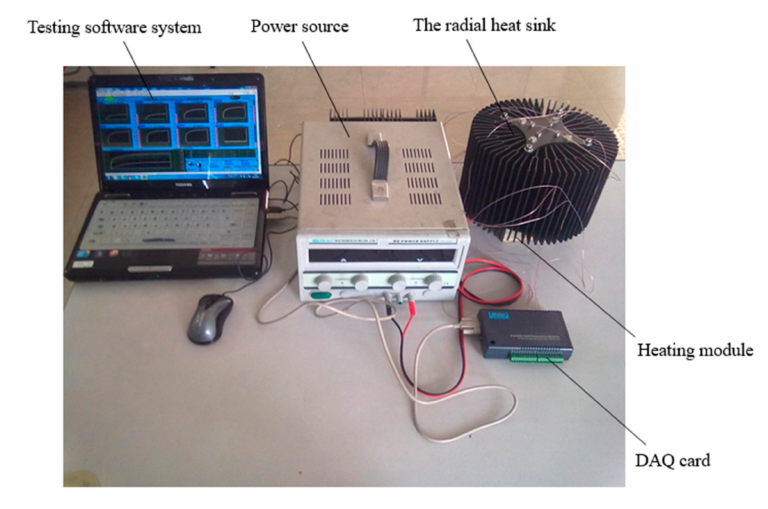
Figure 15. The developed heat transfer performance testing